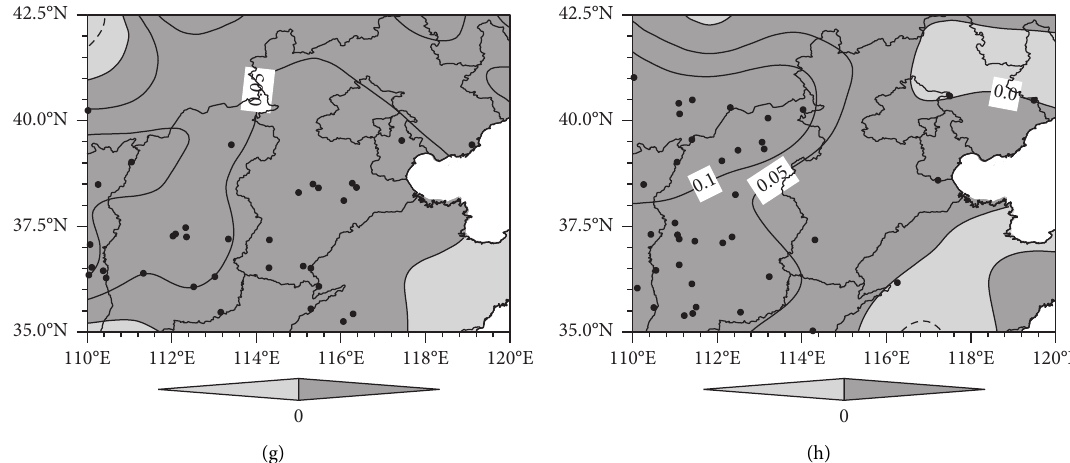
Figure 4: The linear trend distribution of the SSECE frequency in winter (a, e), December (b, f), January (c, g), and February (d, h) in North China during the periods of 1980–2007 (left) and 2009–2016 (right); unit: number of occurrences/a, areas shaded with black dots represent significance at the 90% confidence level using Student’s t -test. (a) Winter_phase I (1980–2007), (b) Dec_phase I (1980–2007), (c) Jan_phase I (1980–2007), (d) Feb_phase I (1980–2007), (e) Winter_phase II (2009–2016), (f) Dec_phase II (2009–2016), (g) Jan_phase II (2009–2016), and (h) Feb_phase II